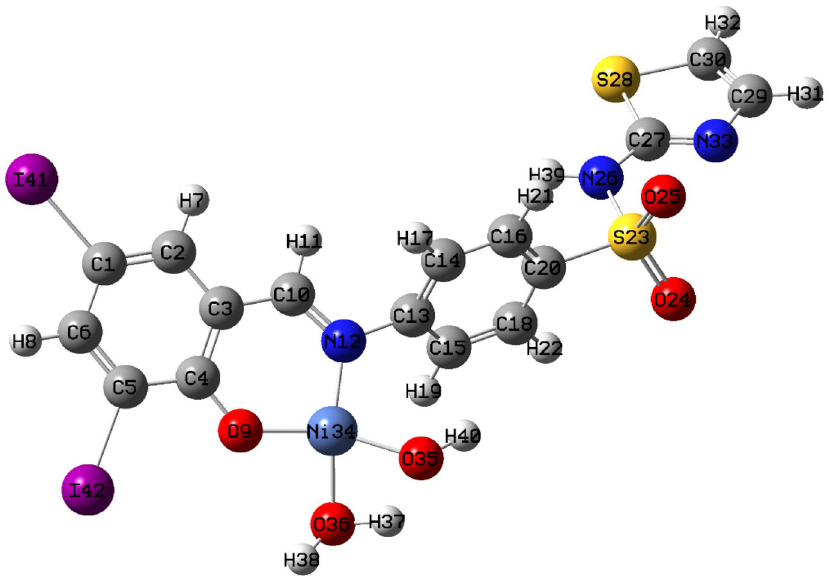
Figure 12. The optimized structure of [Ni(SB 5 –H)(OH)(H 2 O)] complex using DFT-B3LYP Lanl2dz method by GAUSSIAN 09 software version 9.5 and GAUSSVIEW 6.0.16.